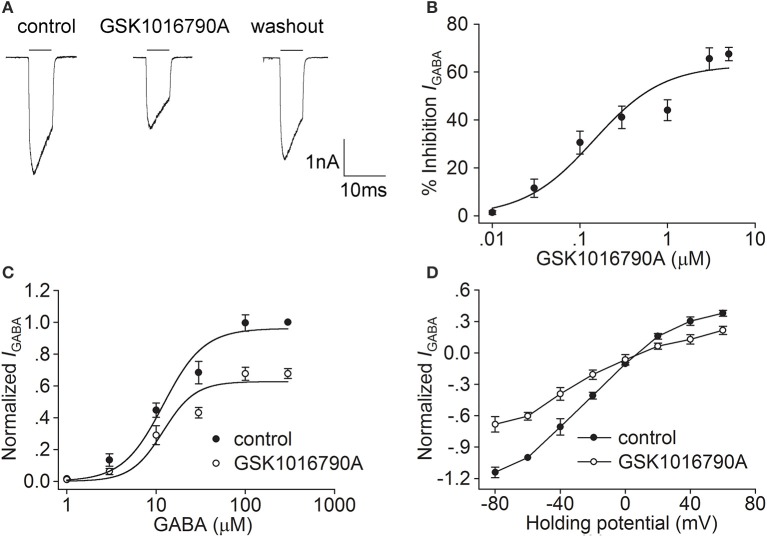
Effect of GSK1016790A on IGABA in hippocampal CA1 pyramidal neurons. (A) The representative recordings show that IGABA (activated by 10 μM GABA) was inhibited from −3.1 to −2.0 nA by 0.3 μM GSK1016790A, and the current recovered to −2.8 nA after washout. (B) The plot shows inhibition of IGABA by GSK1016790A at concentrations of 0.01, 0.03, 0.1, 0.3, 1, 3, and 5 μM. The dose-response curve fits the Hill equation, with IC50value of 0.1 ± 0.05 μM and n of 1.09 ± 0.04. (C) Dose-response curves for IGABA before and during GSK1016790A treatment. Each point represents the normalized current from 8 to 10 neurons. (D) I–V curves for IGABA before and during GSK1016790A treatment. Each point represents the normalized current from 8 to 10 neurons.